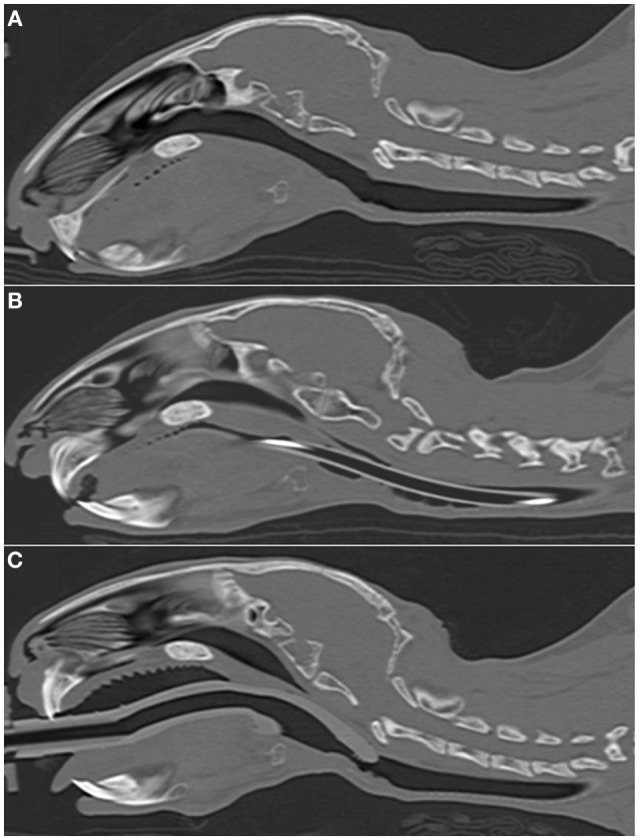
Representative sagittal CT images of rabbits’ heads. (A) 2.7 kg rabbit before airway device placement. (B) 2.7 kg rabbit with an endotracheal tube (2.5 mm ID) inserted into the trachea. (C) 2.7 kg rabbit [same animal as panel (A)] with a supraglottic airway device (SGAD) (SGAD, size R3) inserted. In panel (B), the endotracheal tube is visible passing through the caudal oropharynx, larynx and trachea. Rostral to this, it lies outside the plane of view. In panel (C), the tip of the SGAD enters the larynx, reducing the cross-sectional area (Figure 4).